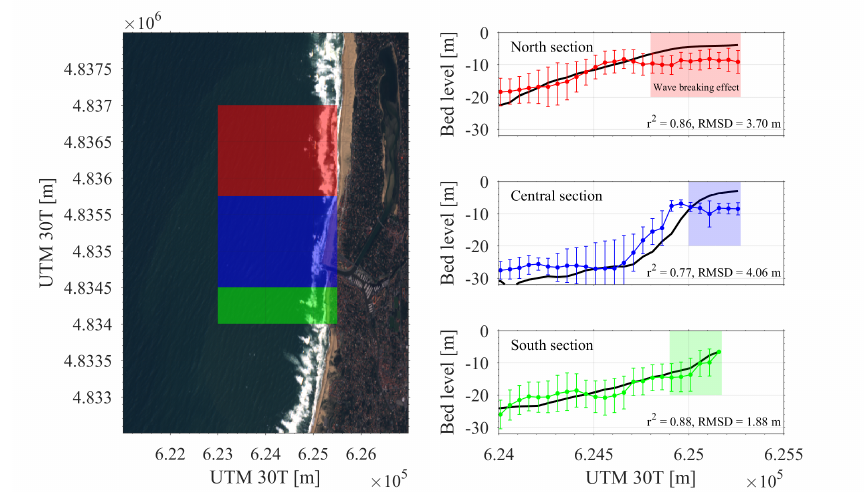
Figure 9. Sectioned profiles considering North of the canyon (red), a central part including the deep water canyon (blue) and South of the canyon (green). The black line illustrates the measured profile while the colors are the estimated profiles using the RT-based depth